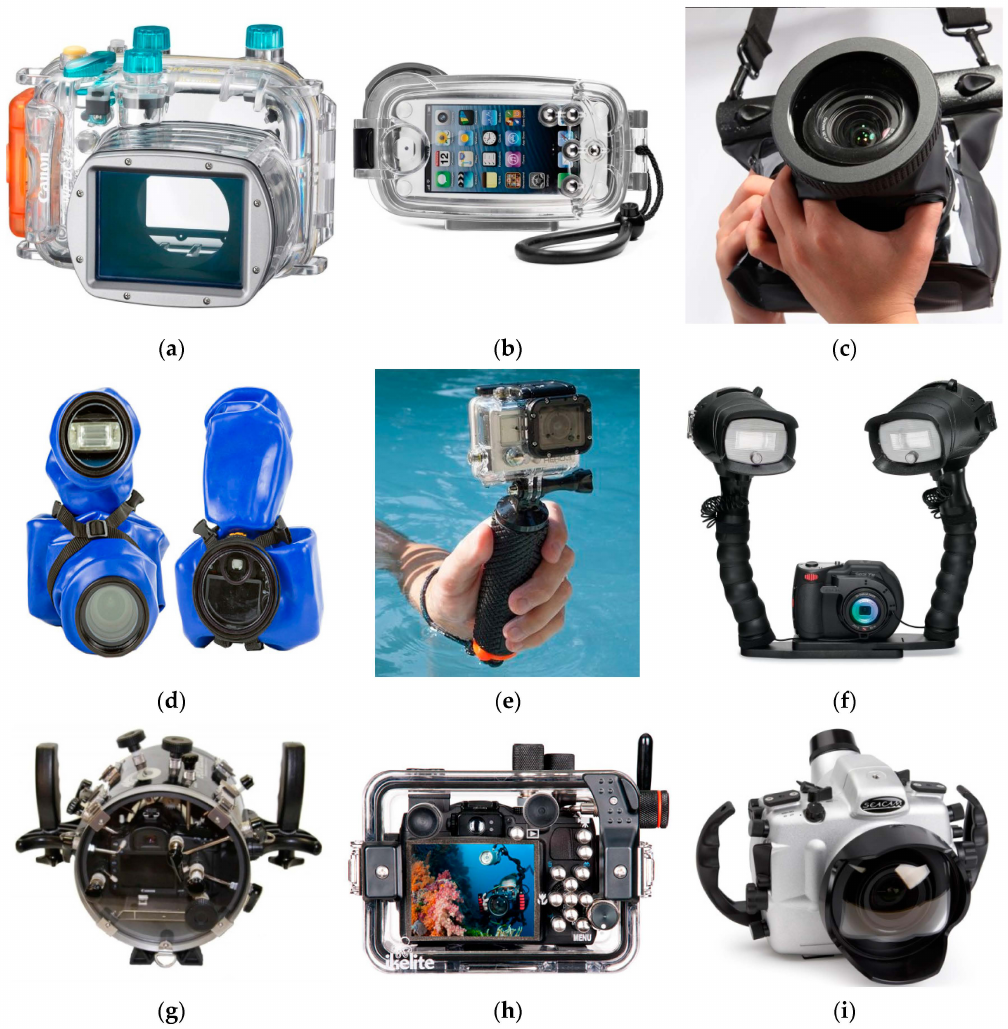
Figure 1. Waterproof housings for digital cameras and flashes: ( a ) Canon with flat port for compact cameras; ( b ) Watershot iPhone housing; ( c ) TteooBL waterproof bag; ( d ) Outex; ( e ) GoPro Hero 3 in its protective waterproof case (Christography); ( f ) Sealife with twin-flash (Hunteroc); ( g ) Equinox Housings for DSLR Nikon; ( h ) Ikelite for Canon; ( i ) Seacam with dome